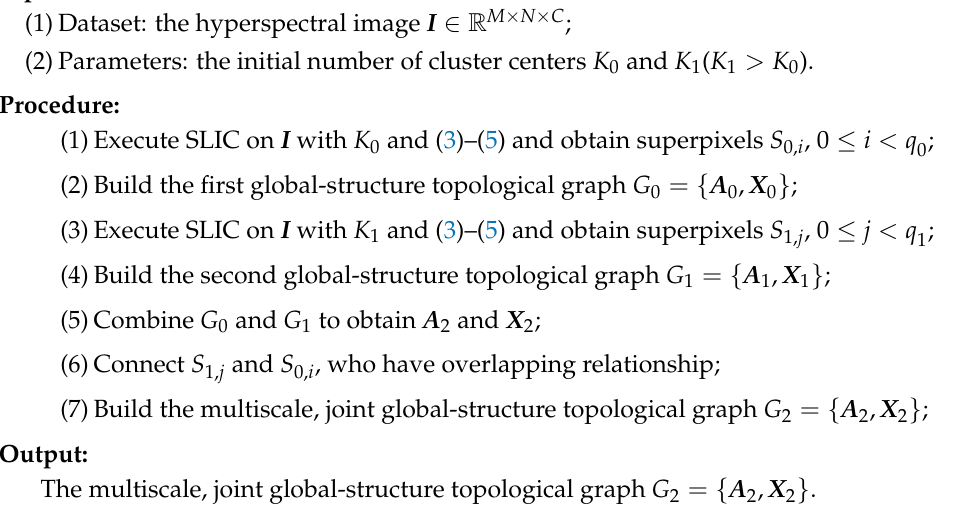
Algorithm 1 Multiscale, Joint Global-Structure Topological